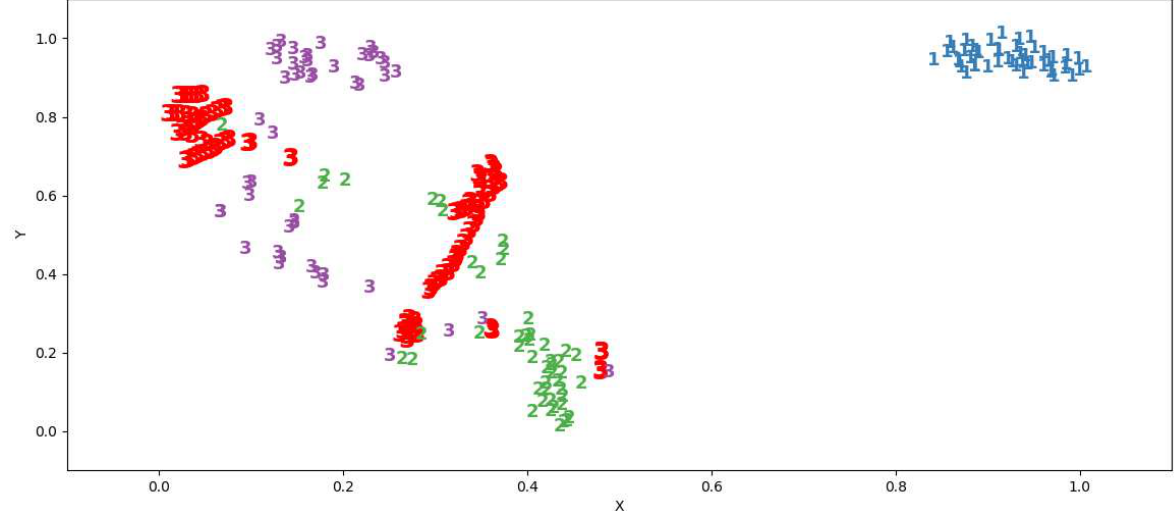
Figure 8. Successful adversarial attacks on the SVM classifier (highlighted in red). Figure 9 shows successful adversarial attacks on the VC classifier.